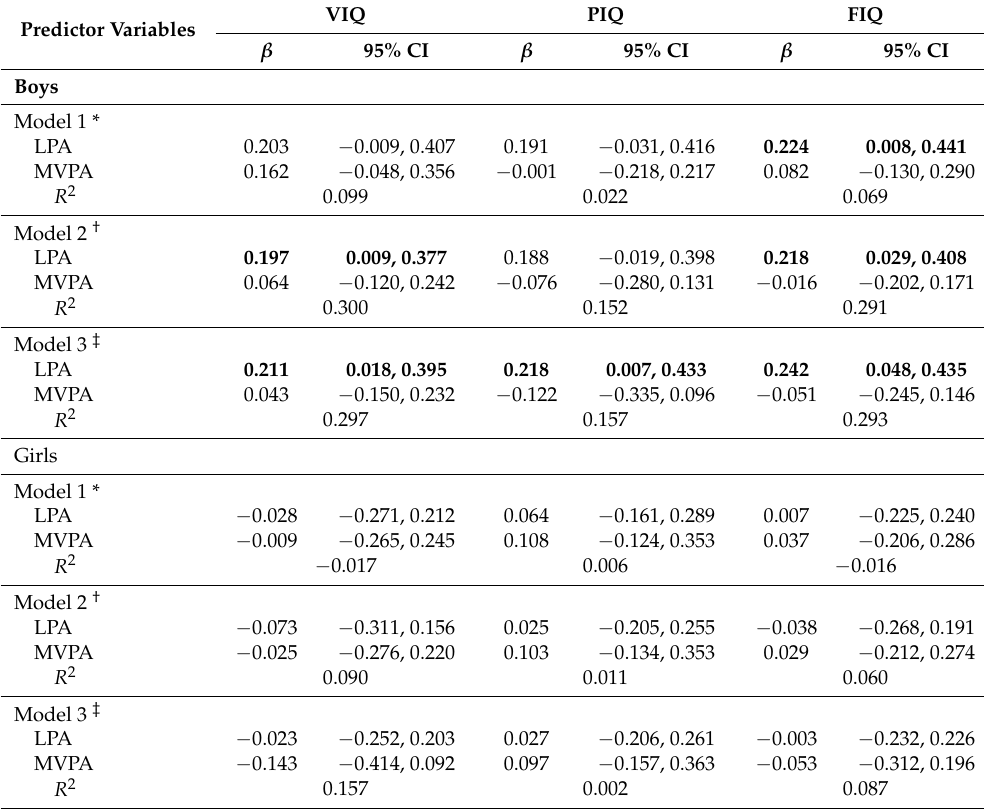
Table 2. Linear regression analyses between cognitive function and physical